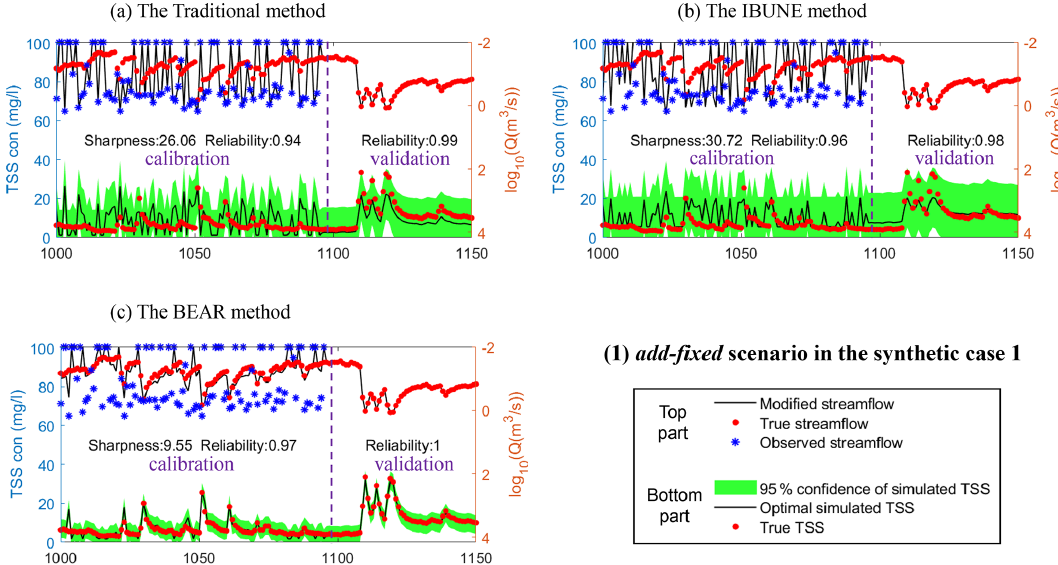
Figure B1. Comparison of the time series of synthetic data and uncertainty bands estimated via three calibration methods (including the traditional method, the IBUNE method, and the BEAR method; algorithms are explained in Sect. 2.4) for a select period of the add-fixed scenario in synthetic case 1 (notations are given in Table 2).